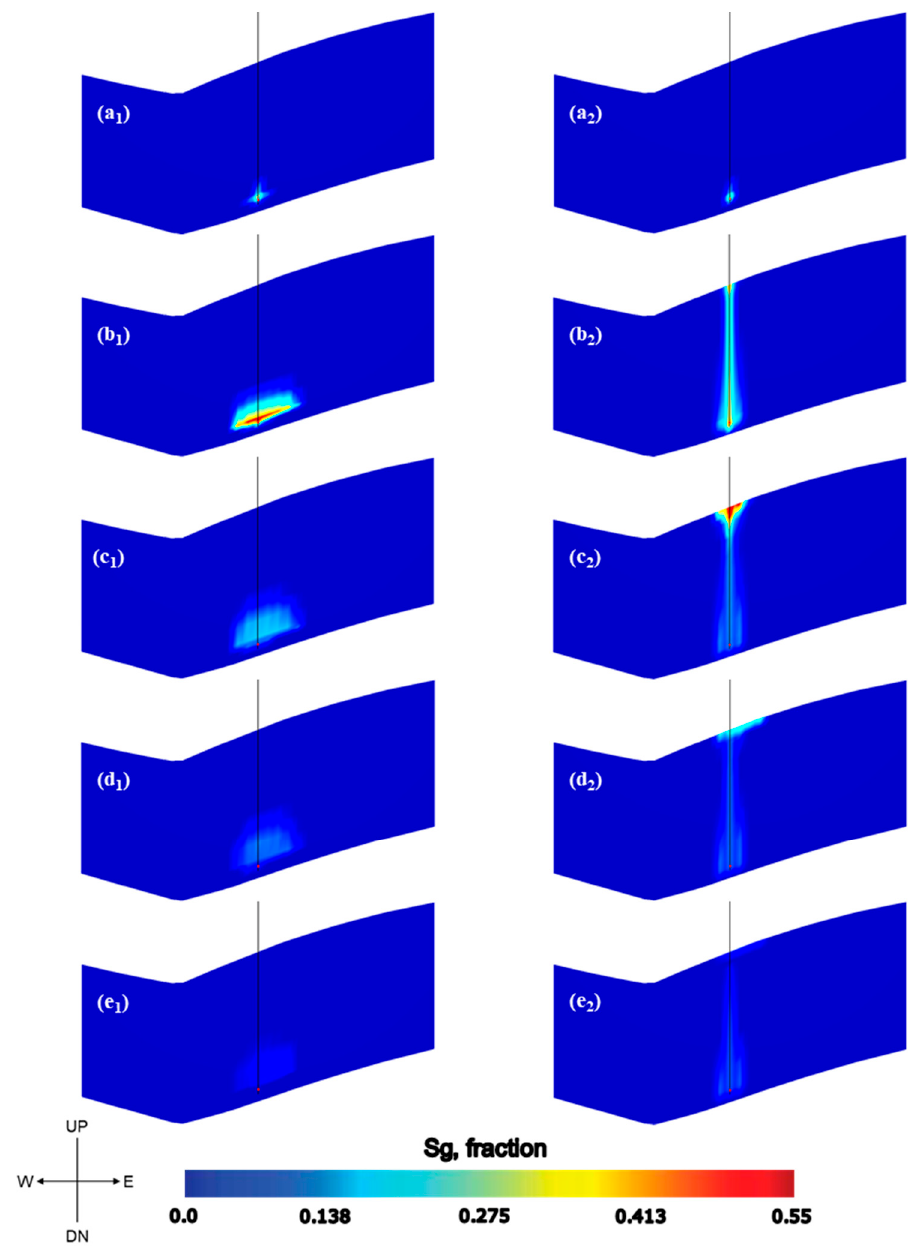
Figure 3. Fence diagrams illustrating the simulated Sg evolution for the base case ( a 1 , b 1 , c 1 , d 1 , e 1 ) and homogeneous case ( a 2 , b 2 , c 2 , d 2 , e 2 ) at ( a ) 1 year, ( b ) 30 years, ( c ) 100 years, ( d ) 1000 years, and ( e ) 10,000 years. Each figure’s size is approximately 35 km × 550 m (x, z).